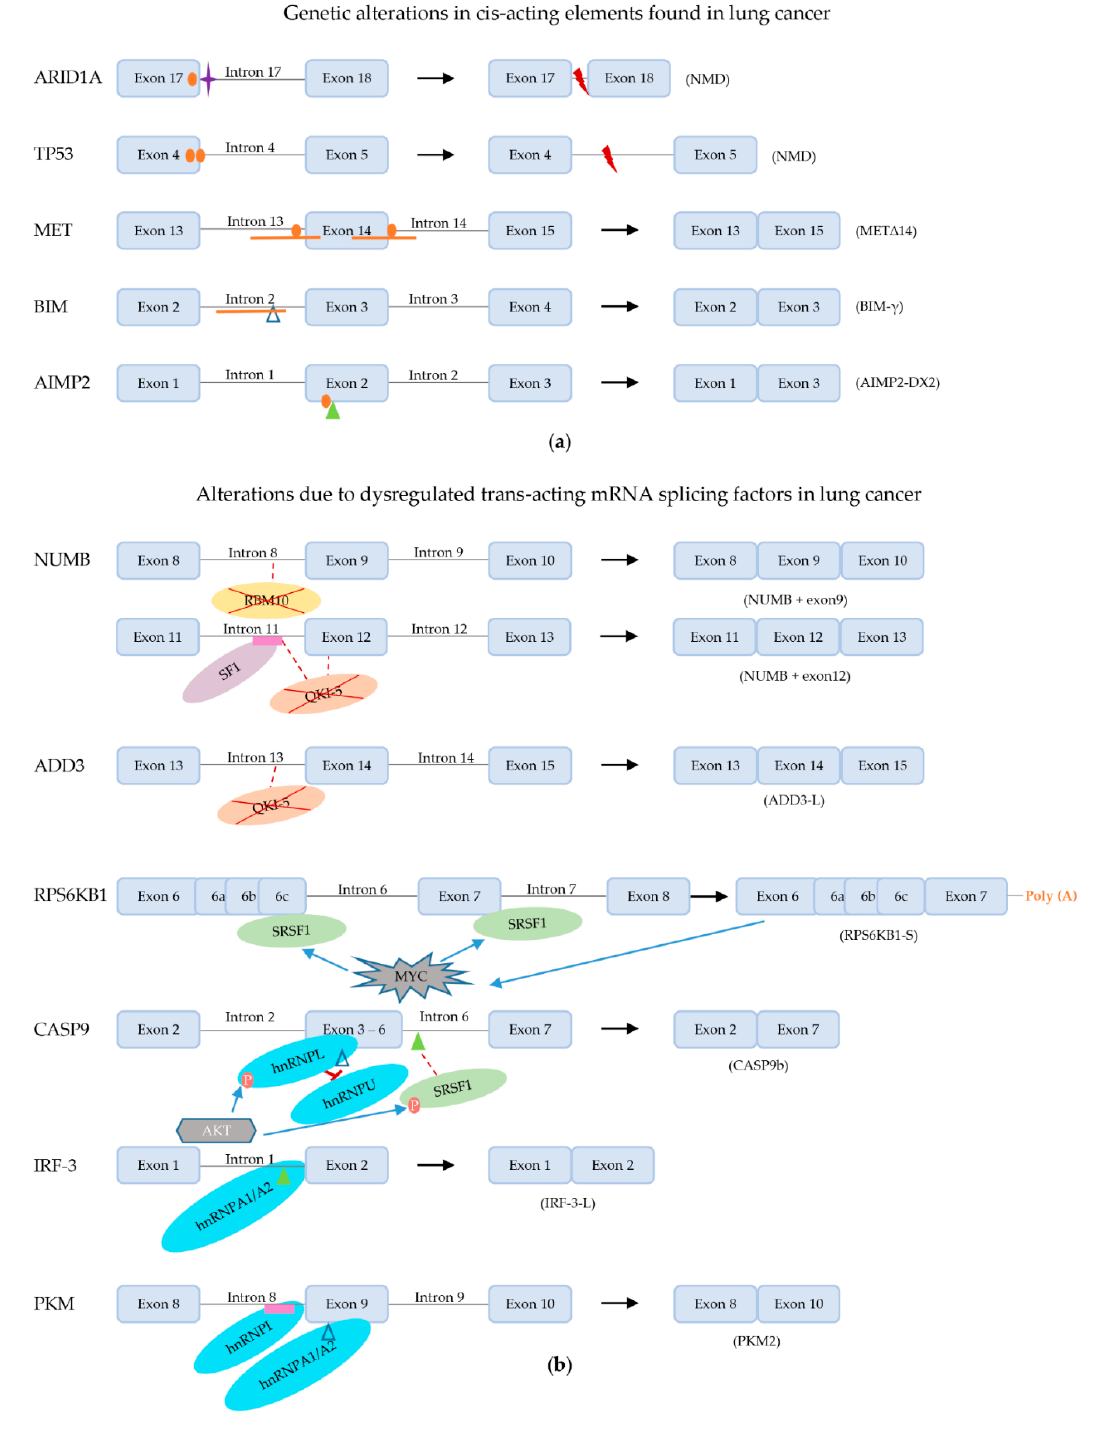
Figure 6. Dysregulation of mRNA splicing in lung cancer ( a ) Genetic alterations in cis-acting elements found in lung cancer. The figure shows aberrant splicing outcomes of lung cancer-related genes with mutations in splicing sites (ARID1A, TP53, MET) or cis-acting regulatory elements (BIM, AIMP2). ( b ) Alterations due to dysregulated trans-acting mRNA splicing factors in lung cancer. Aberrant splicing outcomes of lung cancer-related genes NUMB, ADD3, RPS6KB1, CASP9, IRF-3, and PKM due to splicing factor mutation or abnormal expression. Circle: point mutation; line: deletion mutation; star: intronic cryptic site activation; lightning bolt: premature termination codon in retained intron; open triangle: splicing silencer element; filled triangle: splicing enhancer element; filled rectangle: polypyrimidine tract; P: phosphorylation; dashed line: unbound; arrow: promoting; –I: inhibiting; crossed-out splicing factor: mutational loss.